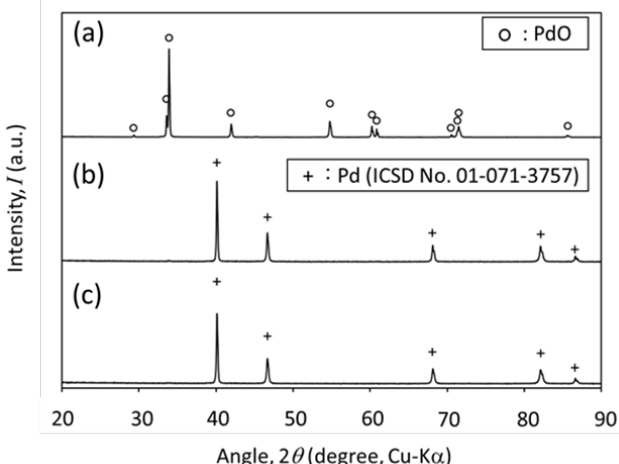
Figure 3. XRD patterns of powders obtained by heating PdO at ( a ) 800 °C, ( b ) 850 °C, and ( c ) 900 °C for 2 h in air.